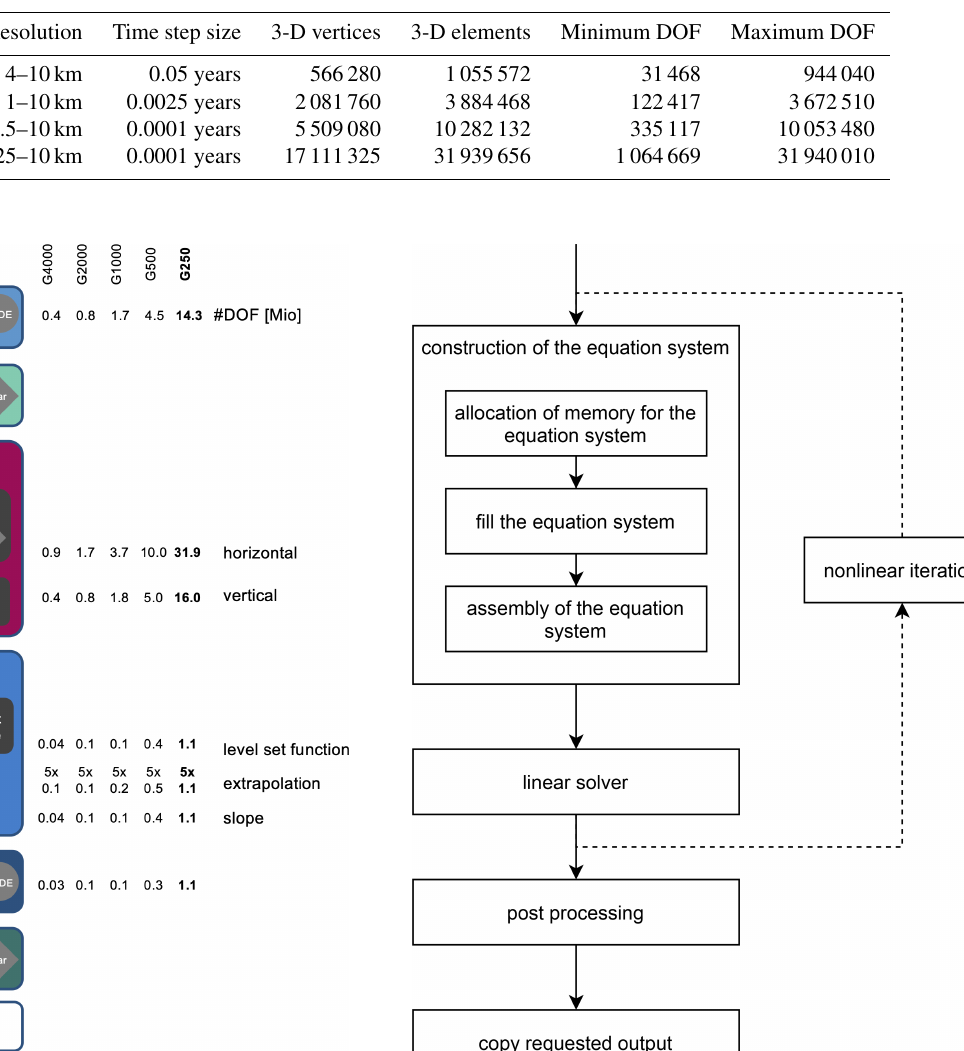
Table 1. Overview of problem setups used in our study. Note that (a) the vertices and elements of the 3-D mesh describe the full mesh (i.e. ice- covered and non-ice-covered elements), (b) the minimum DOF is the DOF from the 2-D mass transport module and (c) the maximum DOF is the DOF from the 3-D stress balance horizontal module.